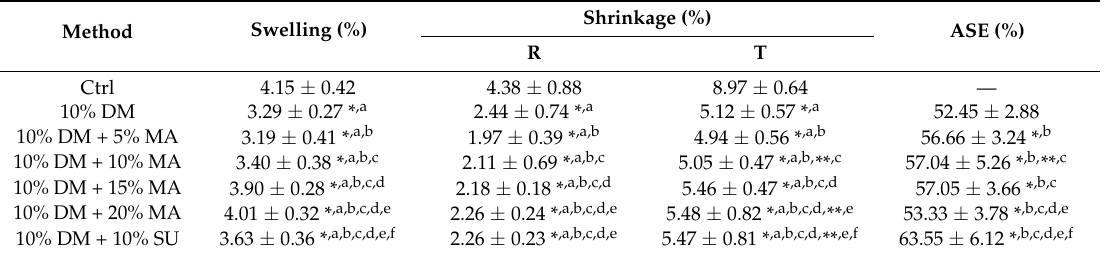
Table 2. Changes in the swelling, shrinkage and ASE of wood treated with different